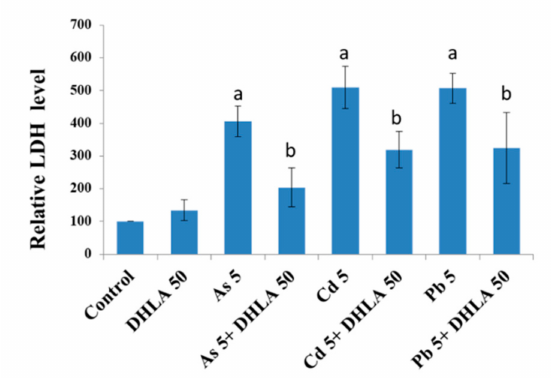
Figure 6. Lactate dehydrogenase (LDH) activity in cell culture medium after exposure to toxic metals and/or DHLA for 48 h of exposure. The values of the bars indicate the mean ± SEM ( n = 3). Here, “a” denotes a significant difference compared to the control group ( p < 0.05), and “b” denotes a significant difference compared to the associated metal group ( p < 0.05).